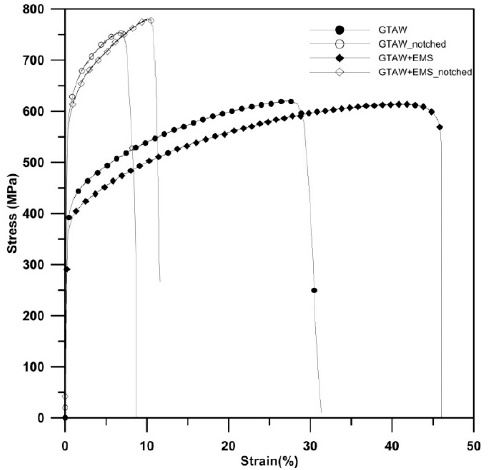
Figure 14. The stress-strain curves for the tensile tests on the CASS weldments at room temperature. Table 7. The tensile test results of the CASS weldments at room temperature.